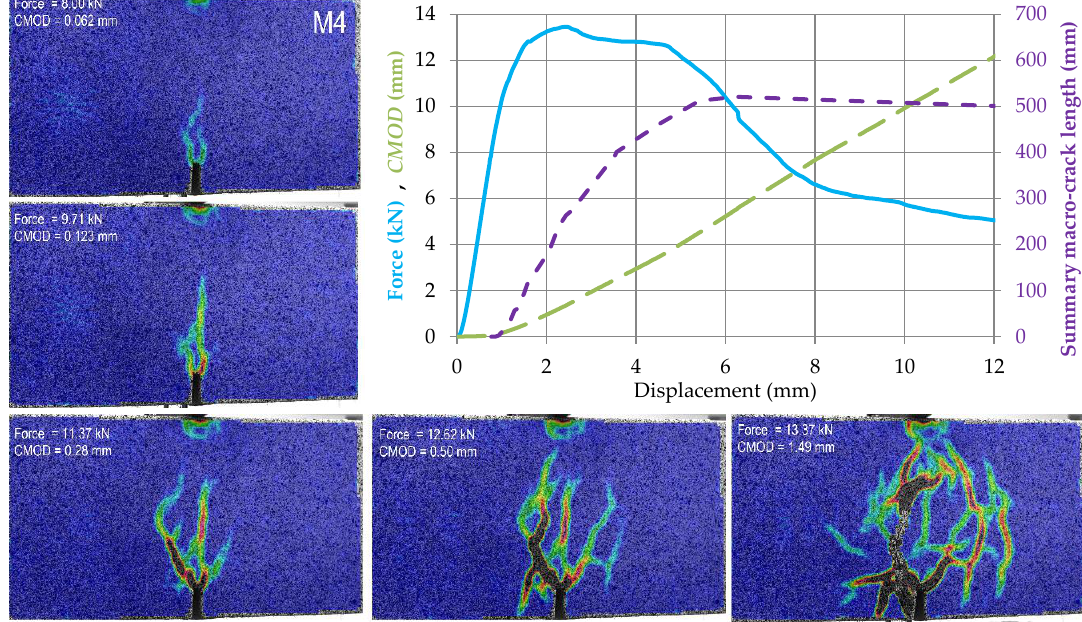
Figure 13. Force, CMOD and summary macrocrack length as a function of displacement in case of material M4 accompanied by cracks development in five chosen stages (contour plots of equivalent Huber–Mises strains).